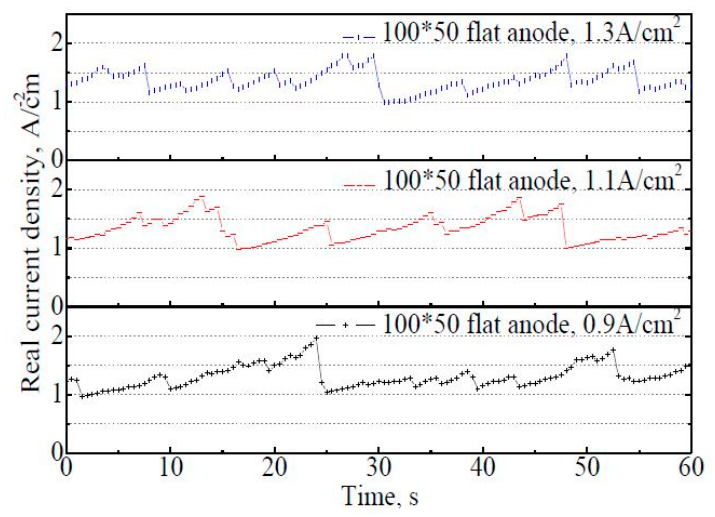
Figure 9. The variation of actual current density on the 100 mm × 50 mm flat anode within 60 s. In Table 2, the bubble size distribution on three tested anodes at 0.9 A · cm − 2 are summarized and compared. The 100 mm × 50 mm flat anode case showed a higher percentage of small bubbles (for every step that bubble size < 300 mm 2 ), in contrast to the 50 mm × 22 mm flat anode case. Table 2. The size distribution of the bubbles obtained from the see-through cell experiments, appar- ent anode current density 0.9 A/cm 2 .